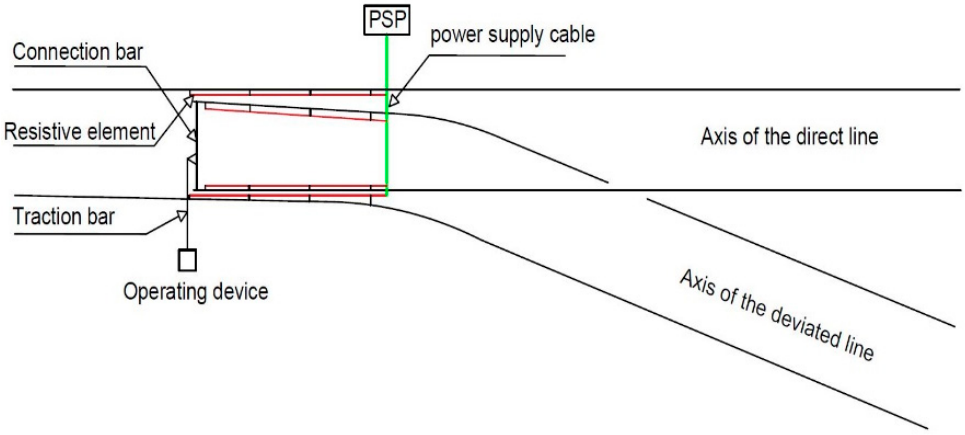
Figure 1. Diagram of a switch equipped with a resistive heating system. PSP = power supply panel. Switches are located at various points in railway stations, including entry points from open lines, access to different lines within stations, and exit points, for changing the train’s path. The distance between the entry switches and the exit switches of a station determines the size or limit of the station. Figure 2 shows a double-line railway station and displays the normal position and numbering of switches, and the distribution of the power supply panels (PSP) for the switch heaters.